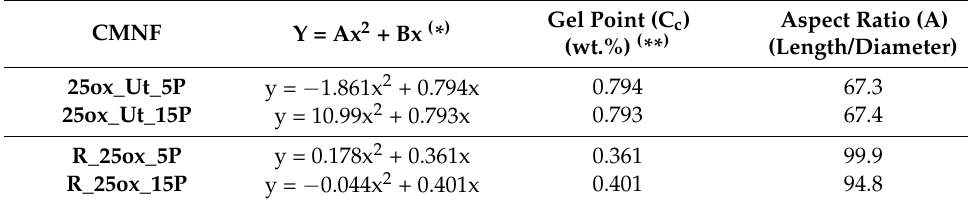
Figure 5. Initial solid concentration vs final sediment height (h s )/initial (h 0 ) height of suspension. Table 6. Sedimentation data fitted with a quadratic equation, gel point (C c ) and aspect ratio (A) of CMNFs according to CN theory.